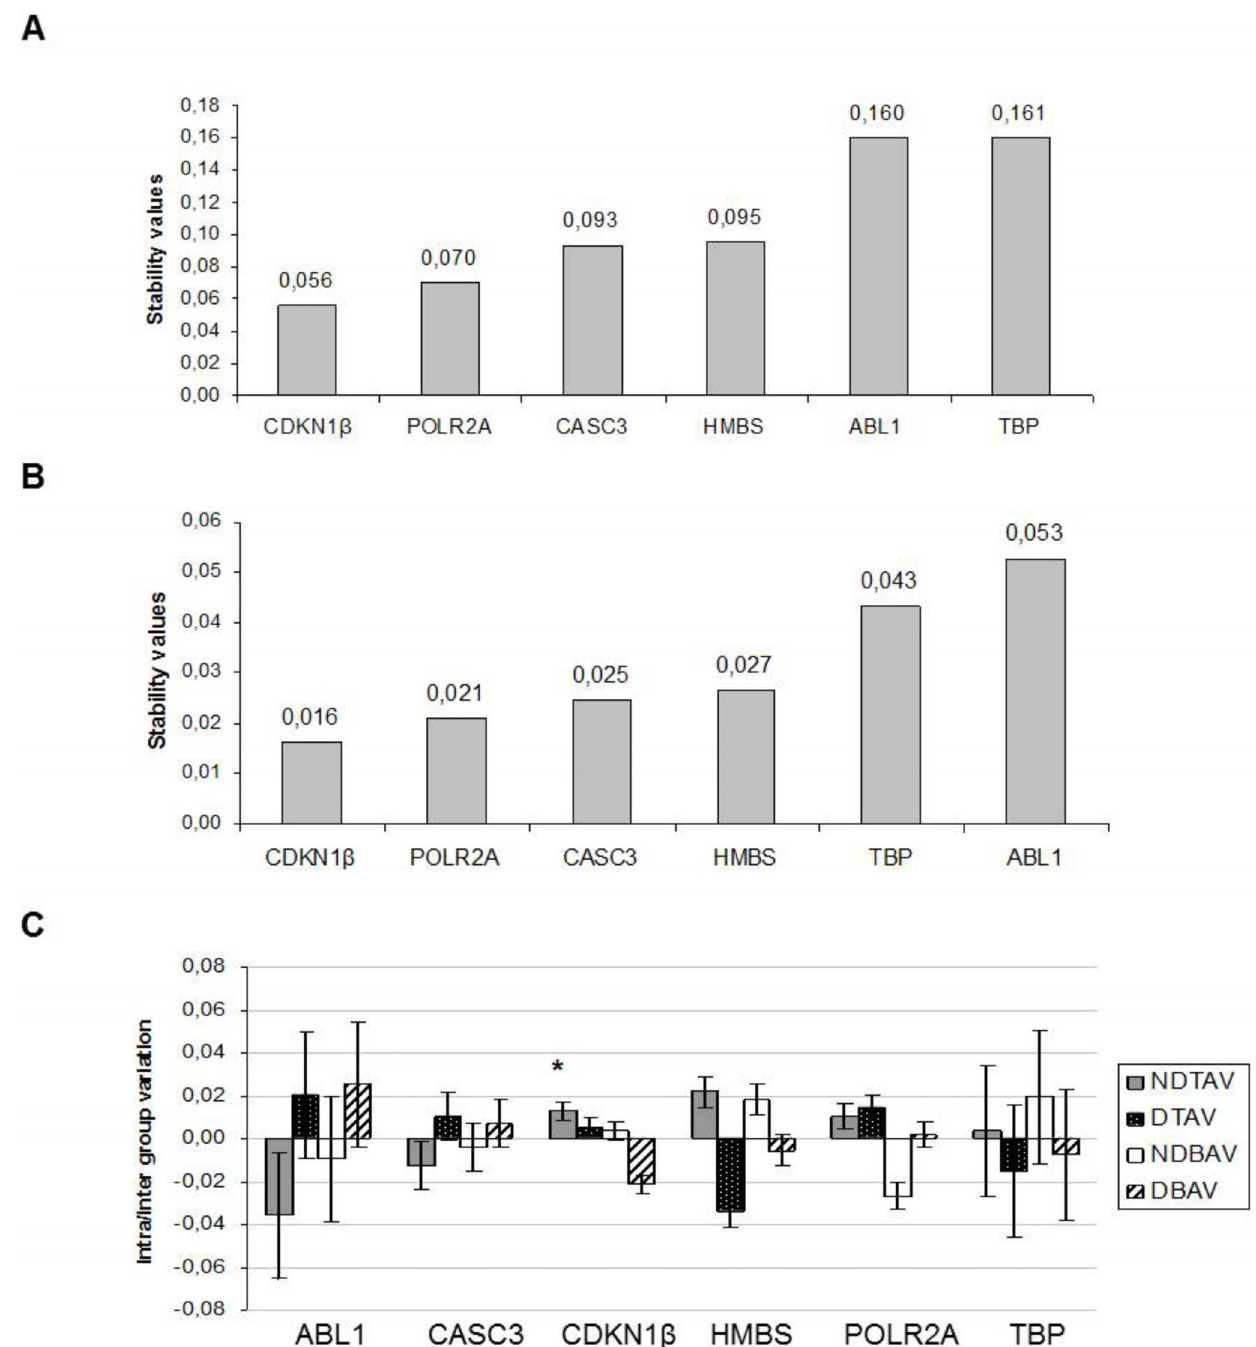
Figure 3. Stability values of reference genes and their variation obtained by NormFinder. A) Stability values considering all the samples in one group. B) Stability values considering the four groups of samples. C) Variation of the stability values in the four groups of samples. In C, the columns represent the inter-group variation and the error bars represent the intra-group variation of the stability value of each reference gene.